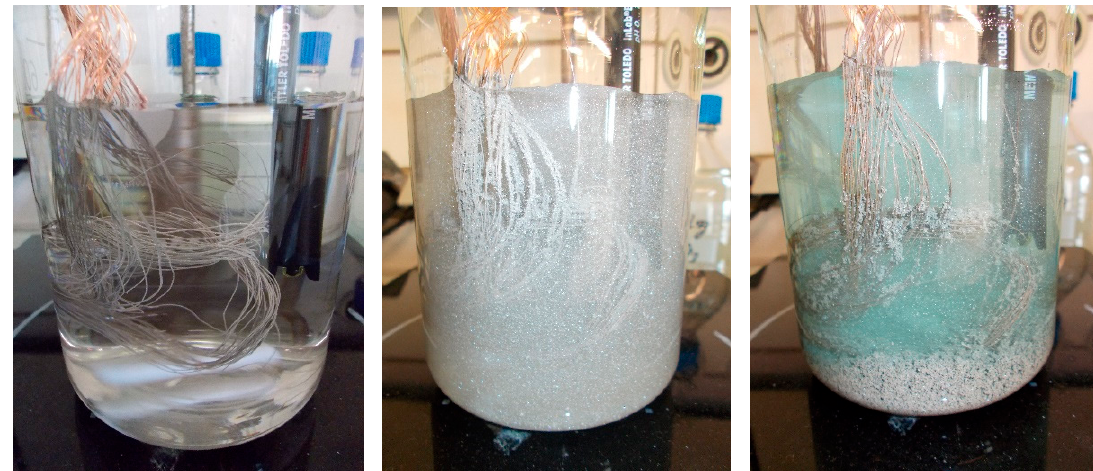
Figure 12. Silver cementation with copper wire in a stirred beaker.